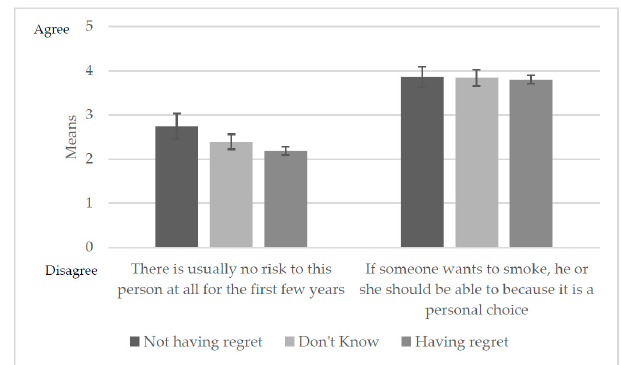
Figure 2. Relative harm perception by smoker’s regret experience.